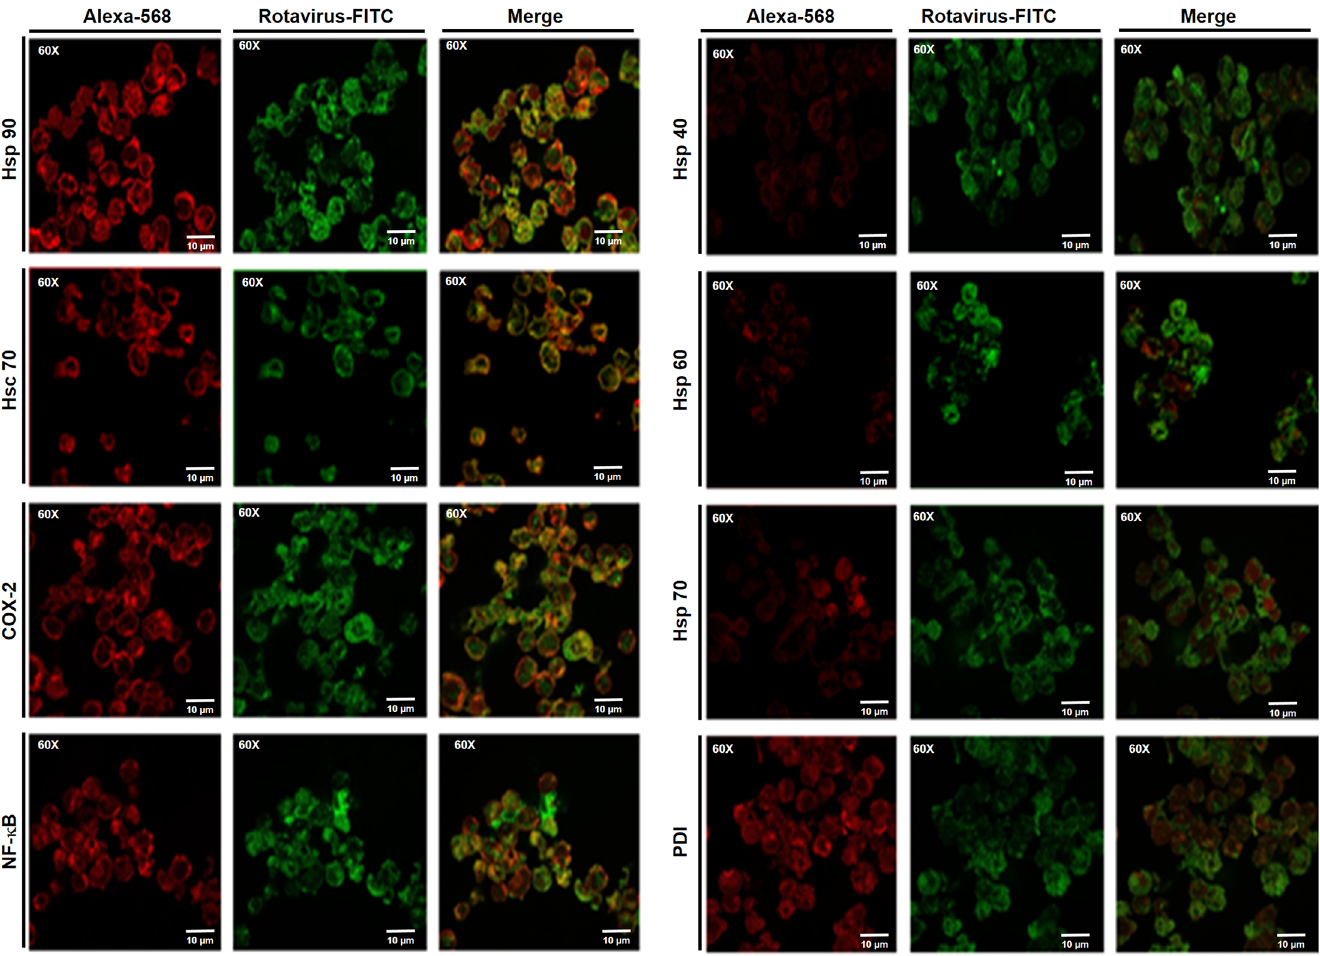
Fig 3. Co-localization of rotavirus structural antigens and cellular proteins HSP90, Hsc70, COX-2 and NF- κ B in tumor cells. Sp2/0-Ag14 cells were infected at a MOI of 0.8 with tumor cell-adapted rotavirus isolates WTEW, TRUY, WT1-5, WWM or ECwt. Cells were harvested at 12 h.p.i., fixed with PFA and permeabilized. Co-localization was assessed using antibodies against viral SP (green) and cellular proteins Hsp90, Hsc70, Hsp60, Hsp40, Hsc70, PDI, COX-2 and NF- κ B (red) using confocal microscopy. Merged images appearing yellow suggest co-localization.